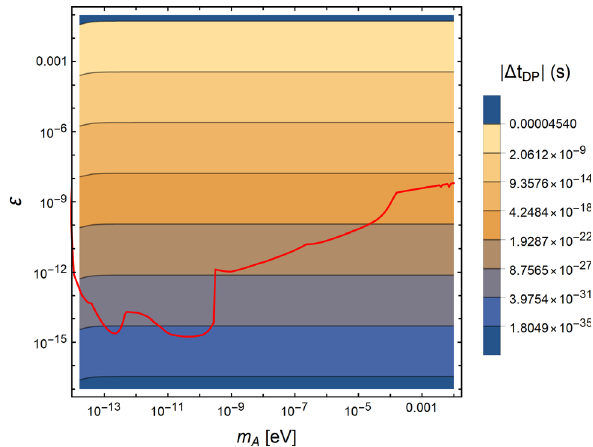
Fig. 3 Extratimedelay Δ t DP (12)duetoDPDMfortheregion m A (cid:3) ≥ ω ν = 1 . 23GHz, ν = 1 . 53GHz and p . We used the FRB 121102 ( l h z = 0 . 193),howeverallotherFRBspresentvirtuallythesamebehavior. It is shown in red the existing limits, as in Fig.